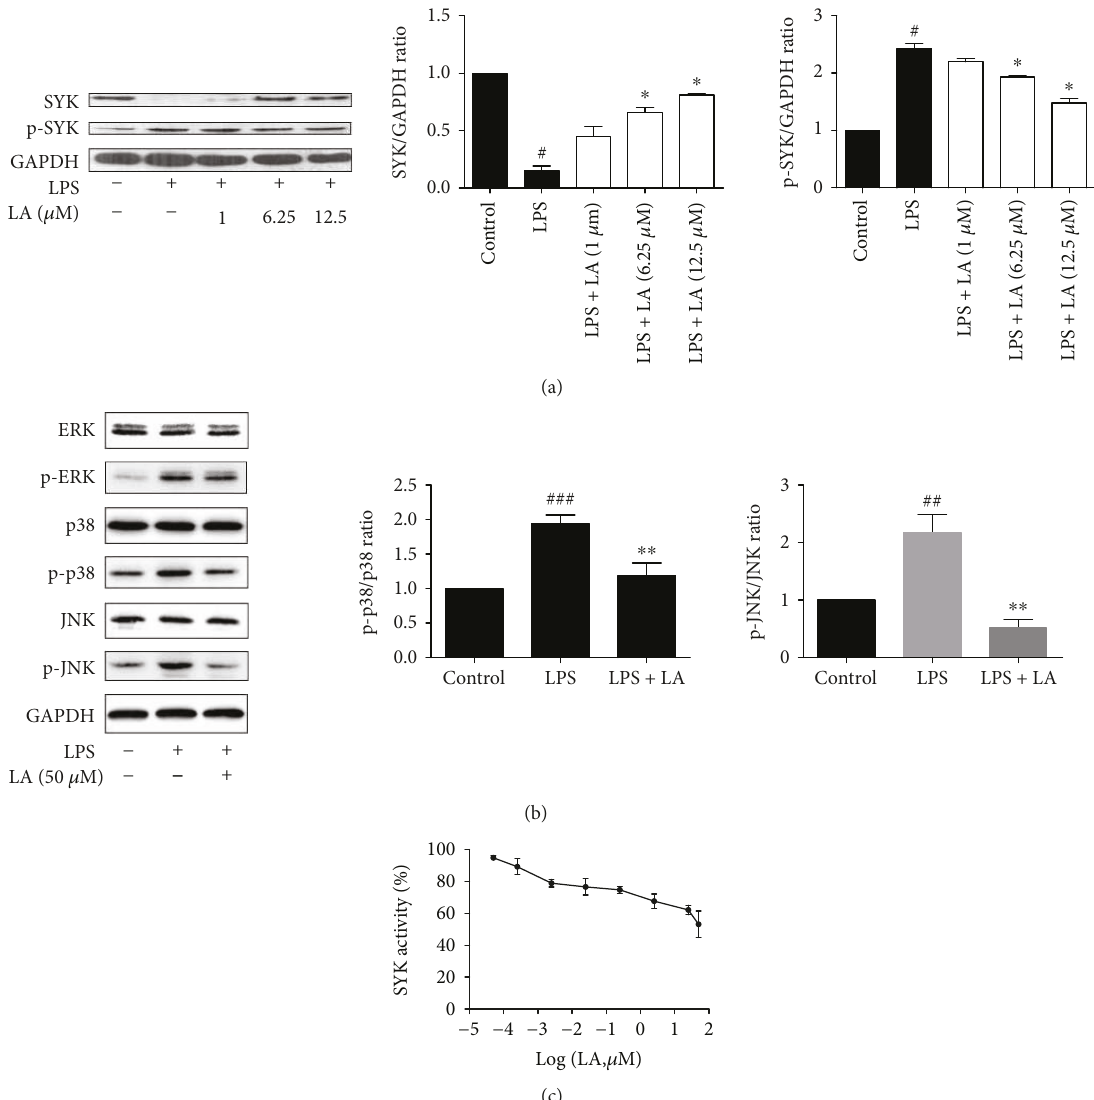
Figure 2: LA inhibited Syk and p38/JNK activity. HUVECs were pretreated in the presence of various doses of LA for 1h and stimulated with LPS for 30 min. A Western blotting analysis was performed to evaluate the levels of phosphorylated Syk and total Syk (a). HUVECs were treated with 50 μ M of LA for 1 h before LPS stimulation for 15 min, and then the total proteins of cells were extracted. The activation of the MAPK (b) pathways was detected using Western blotting with speci fi c antibodies. Syk activity was analyzed using an in vitro kinase assay through recombinant Syk obtained from Promega. The assay (ADP-Glo kinase assay) was performed to measure luminescent signals by using Ultra-Glo Luciferase; its ADP from a kinase reaction is converted into ATP converted into light. Kinase assays were conducted in the presence of various doses of LA for 30min. The results were evaluated using Syk activity (c). Data represent the mean ± SD of at least three independent experiments, and each experiment was performed in triplicate. # p < 0 05 ## p < 0 01 and ### p < 0 001 versus control alone; ∗ p < 0 05 ∗∗ p < 0 01 versus LPS